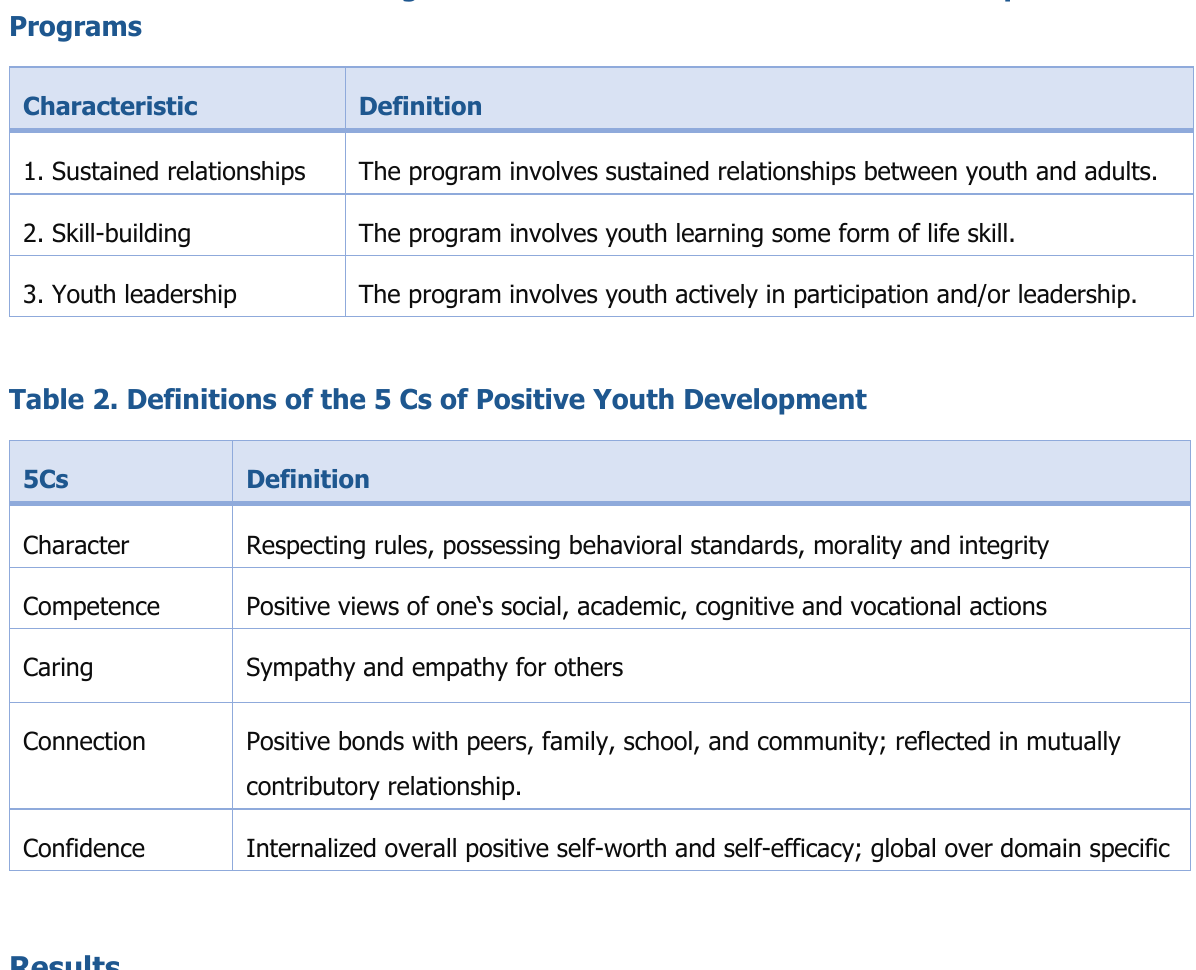
Table 1. Definitions of the Big 3 Characteristics of Positive Youth Development